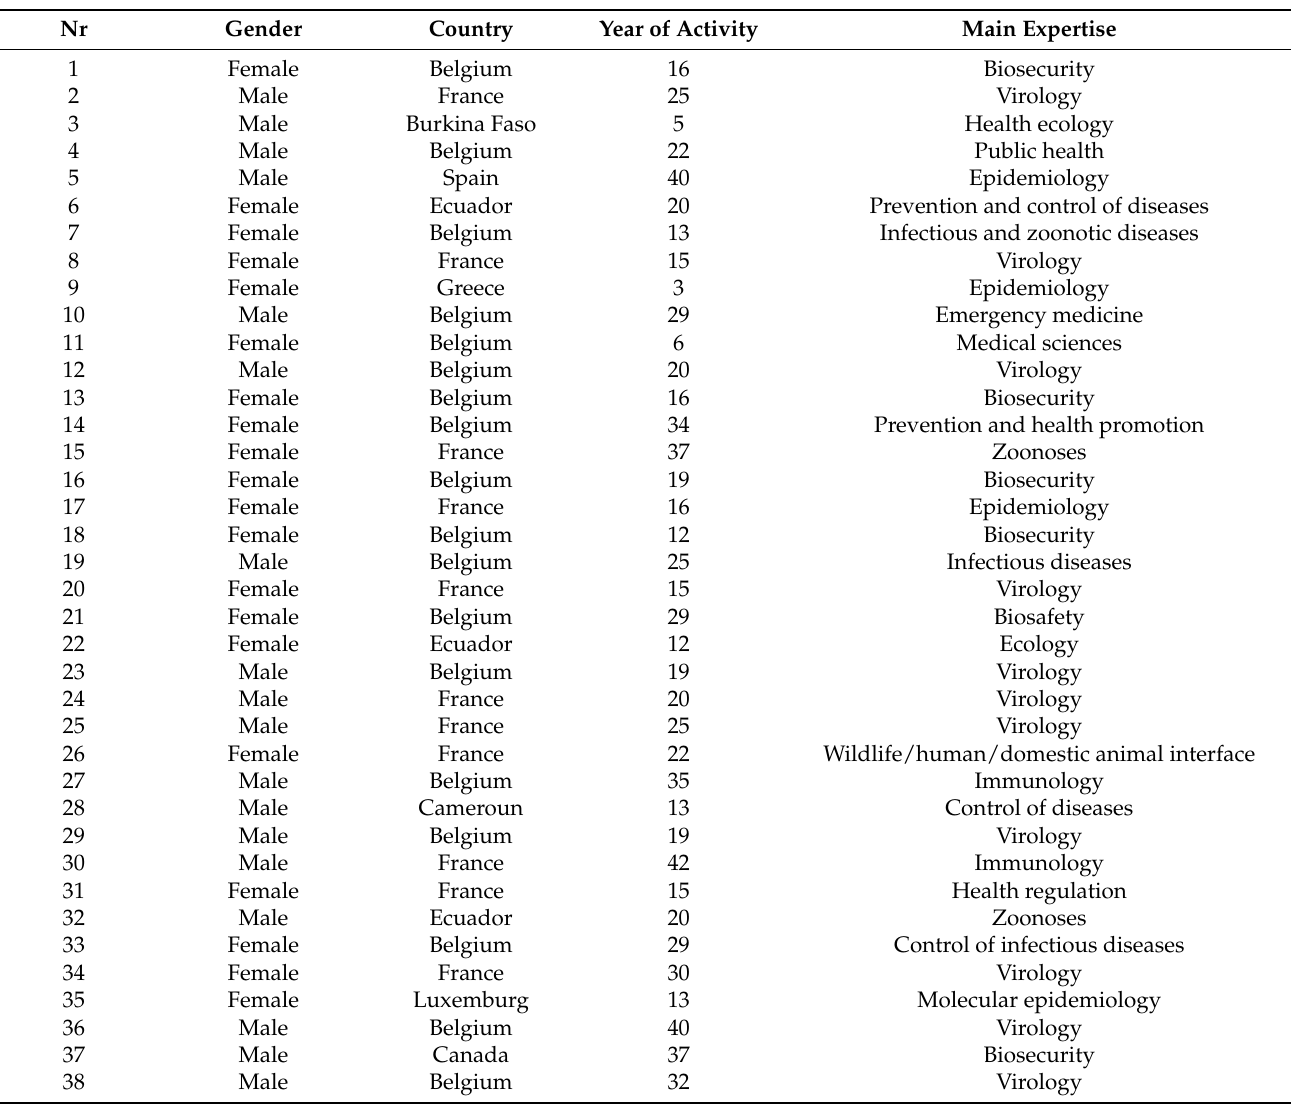
Table A2. Profiles of elicited